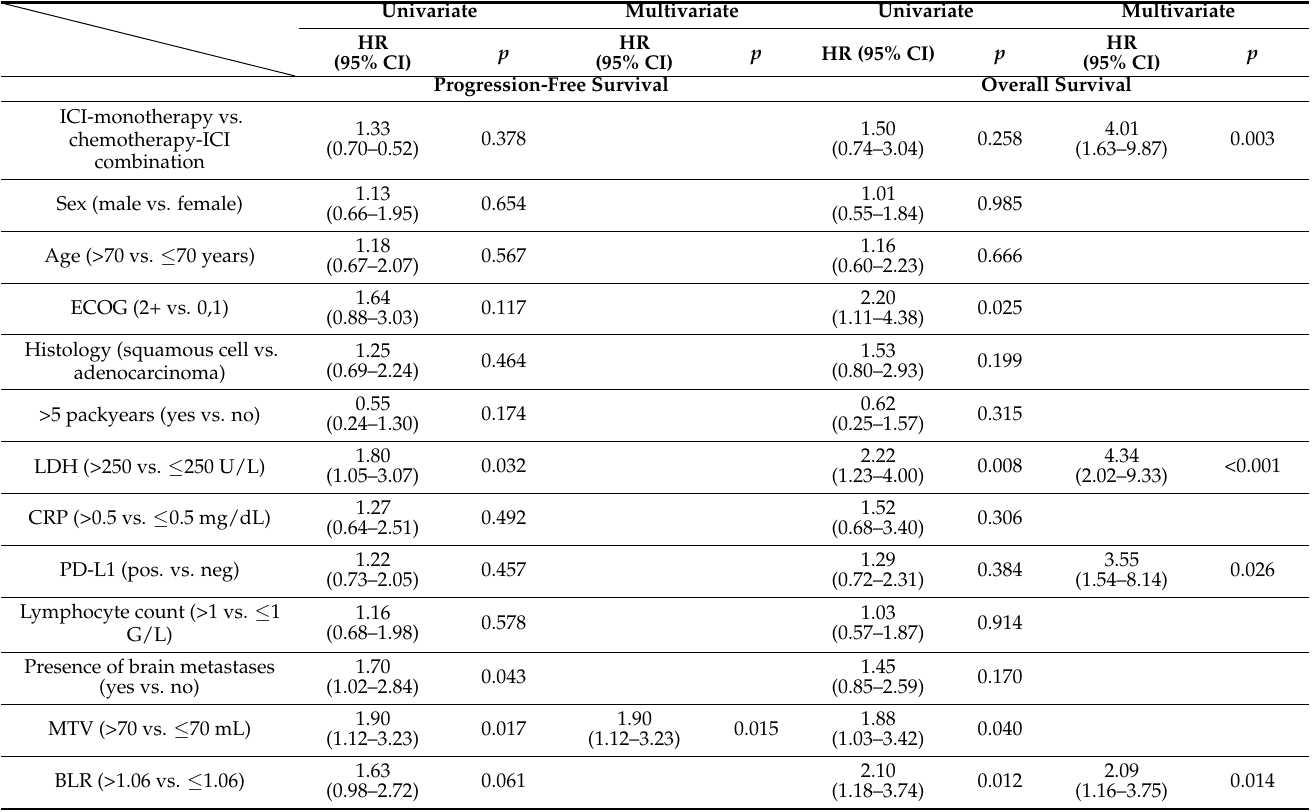
Table 4. Uni- and multivariate analyses for progression-free and overall survival in all patients with full dataset avail- able ( n = 73). p -value indicates the statistical significance of the hazard ratio. HR = hazard ratio, CI = confidence in- terval, ICI = immune checkpoint inhibitor, ECOG = Eastern Cooperative Oncology Group, SD = standard deviation, IQR = interquartile range, NSCLC = non-small cell lung cancer, LDH = lactate dehydrogenase, CRP = C-reactive protein, PD-L1 = programmed death-ligand 1, MTV = metabolic tumor volume, BLR = bone marrow to liver ratio.